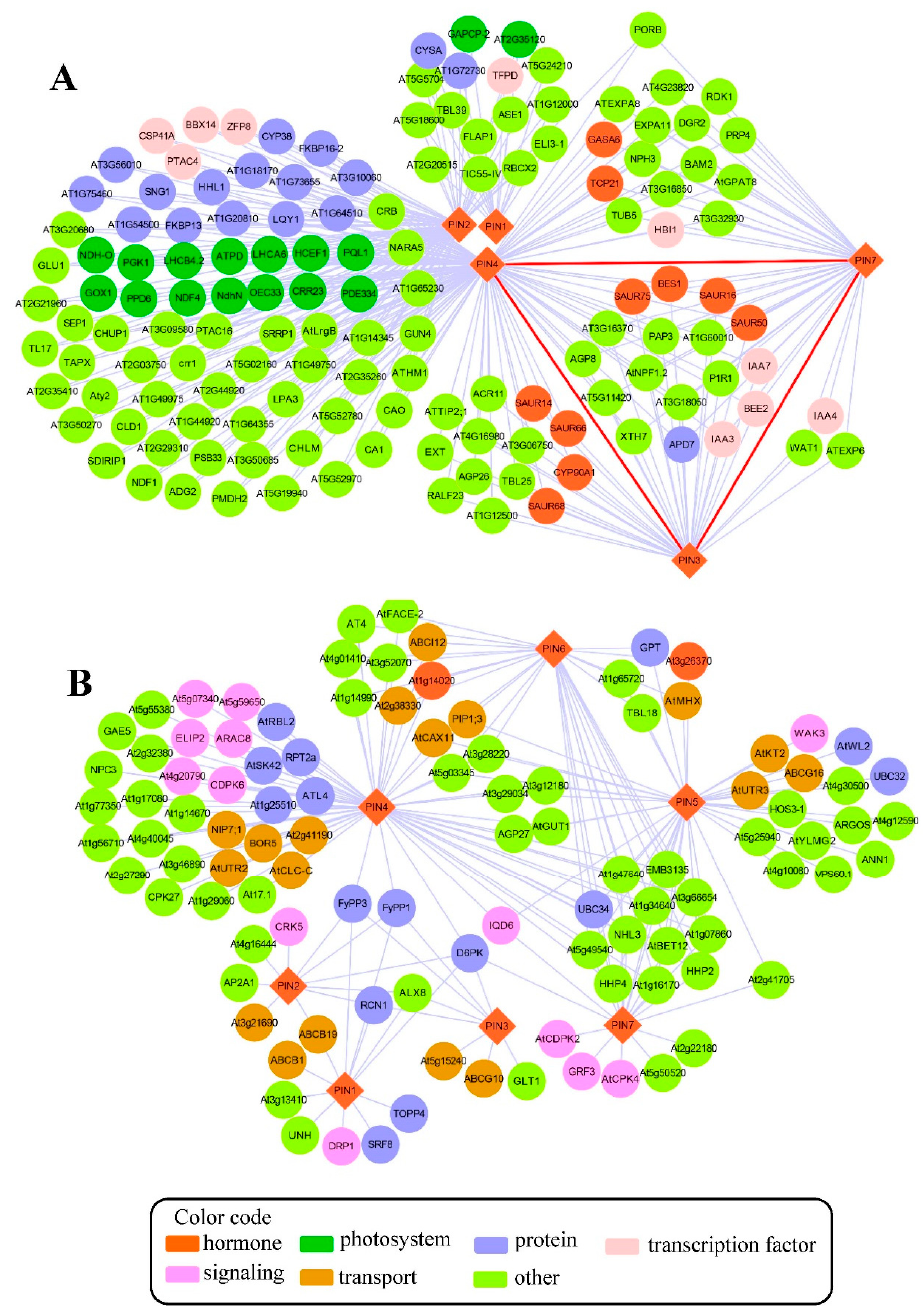
Figure 2. ( A ) The co-expression network of PIN genes and ( B ) the PIN protein interaction network in Arabidopsis . The network was constructed using an online database, CressExpress (available online: http://cressexpress.org/home.xhtml). This was done using pathway-level co-expression (PLC) analysis as suggested by Wei et al. [71] and visualized in Cytoscape (3.5.0) [86]. In the co-expression network, the lines between nodes represent significant correlations between two genes. The red lines represent significant correlations between PIN genes. The protein-protein interaction network was constructed using Cytoscape with data from the BioGRID database [87] (available online: https://thebiogrid.org/). In the PIN protein interaction network, the lines between nodes represent physical interactions verified by experimental approaches (for detail, see Table S1). The PIN genes/PIN proteins are represented by diamonds, and other co-expressed genes/interactive proteins are represented by circles. The different colors indicate different functional categories assigned by Mapman software [88], as shown by color codes.